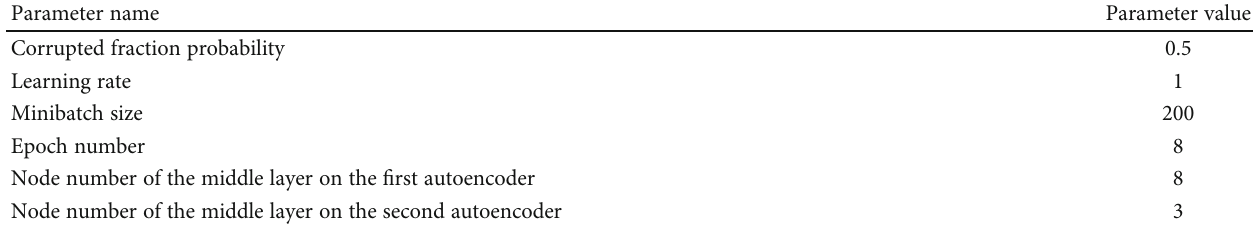
Table 1: The parameter setting of the SDAE model.